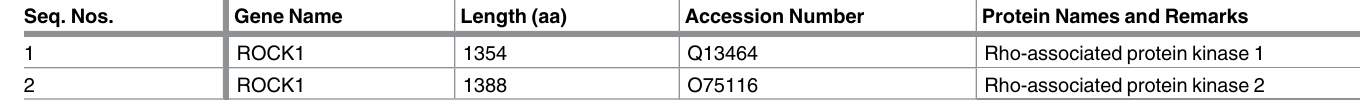
Table 7. Details of Rho-associated protein kinase family members in human. Seq. Nos.